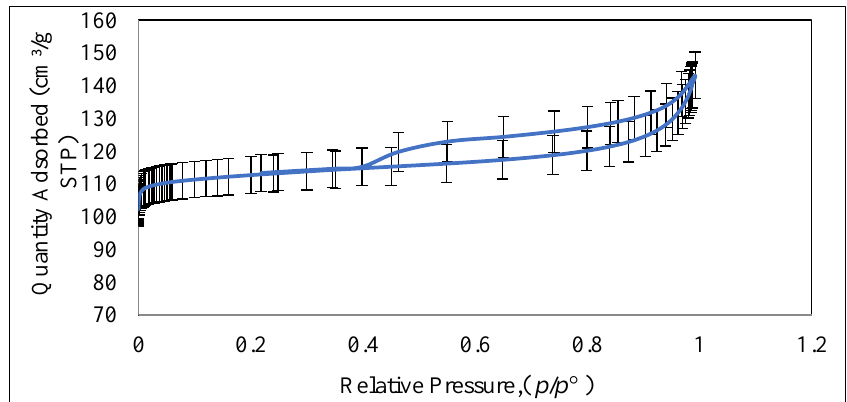
Figure 10. Nitrogen adsorption–desorption isotherms of Ch/g-HNTs@Zn γ M nanocomposites.